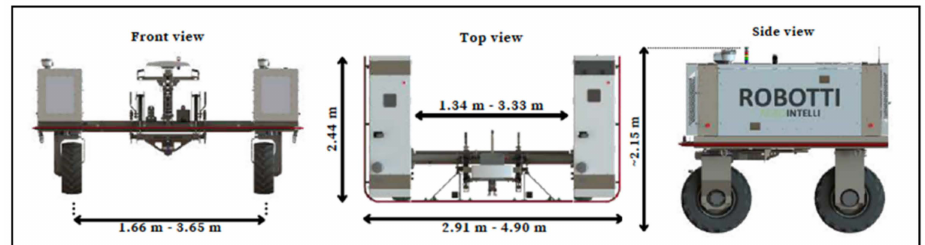
Figure 1. The robotic